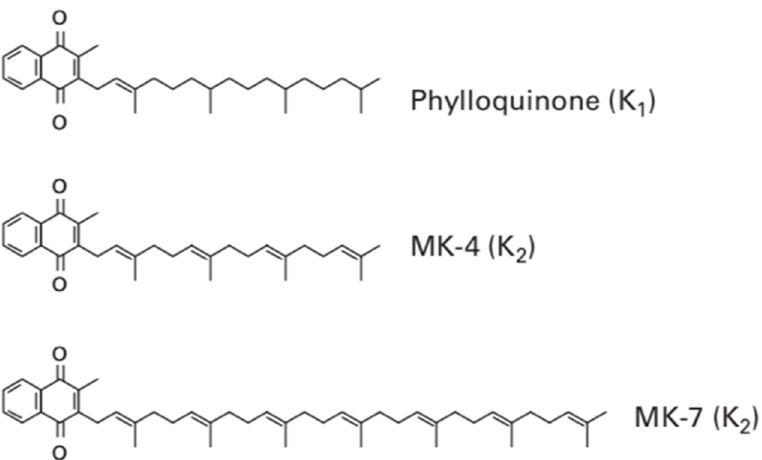
Figure 1. The chemical structure of Vitamin K. Phylloquinone is shown to contain repeating prenyl units, where it is bonded to the third carbon on the menadione ring. In comparison, MK-4 and MK-7 contain the same menadione ring, though it is the prenyl repeating units that bond to the third carbon. The length of the MK-7 chain is three units longer, which is what gives it a longer half-life compared to MK ‐ 4 [8].